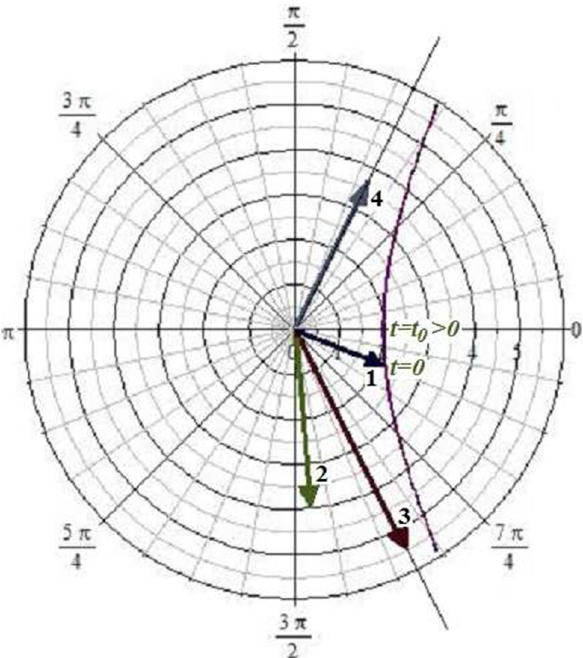
Fig. 1 de Sittertimelikegeodesic with φ 0 = 0 and t 0 > 0. The marked